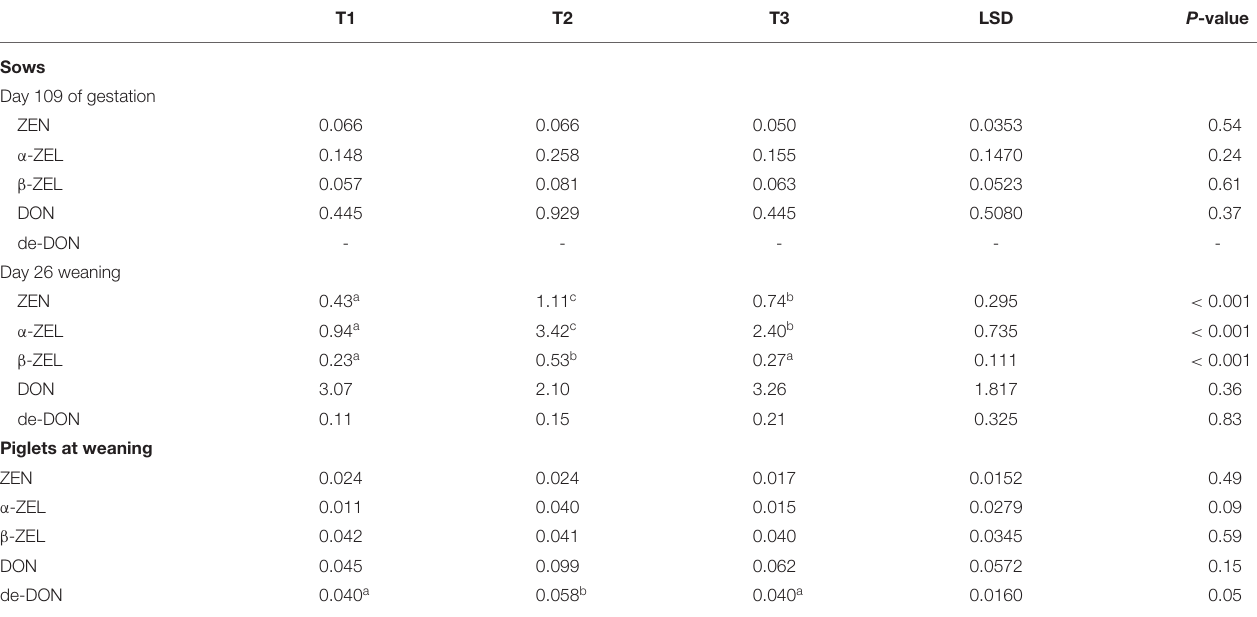
TABLE 7 | Effect of treatments on the mycotoxin levels (ng/ml) in the serum of sows and piglets. T1 T2 T3 LSD P